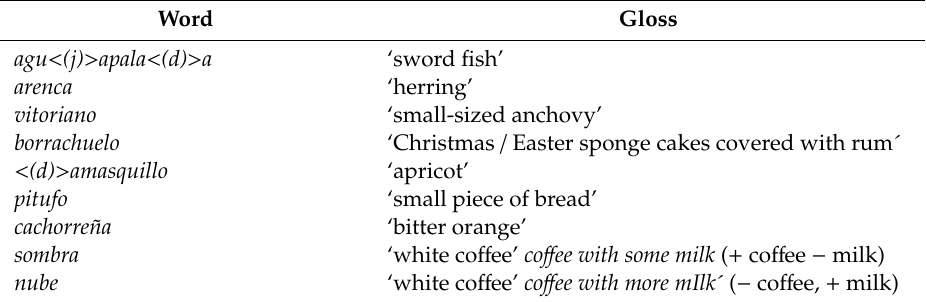
Table 2. Proximity lexicon employed in the experiment ( Á vila-Muñoz 2017).